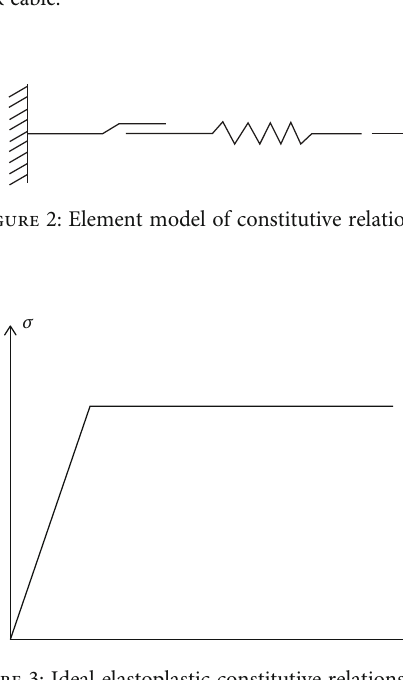
Figure 1: Structure of the CR cable.